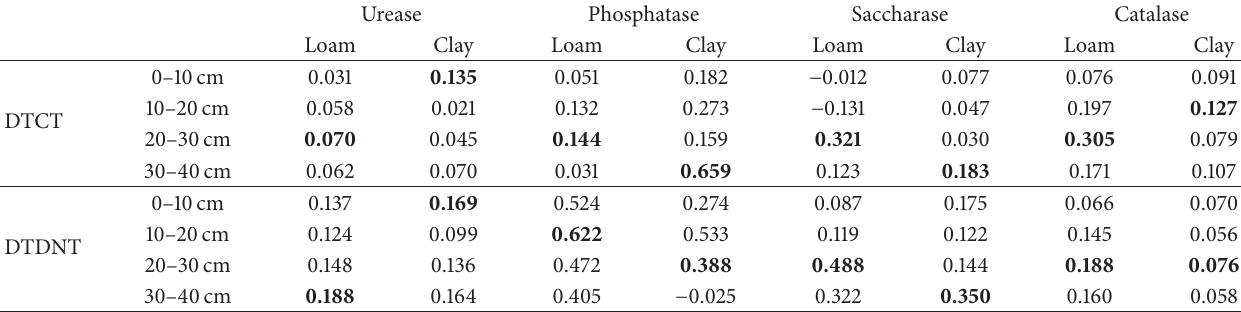
Table 3: DTCT and DTDNT values of urease, phosphatase, saccharase, and catalase activities in loam and clay soil.